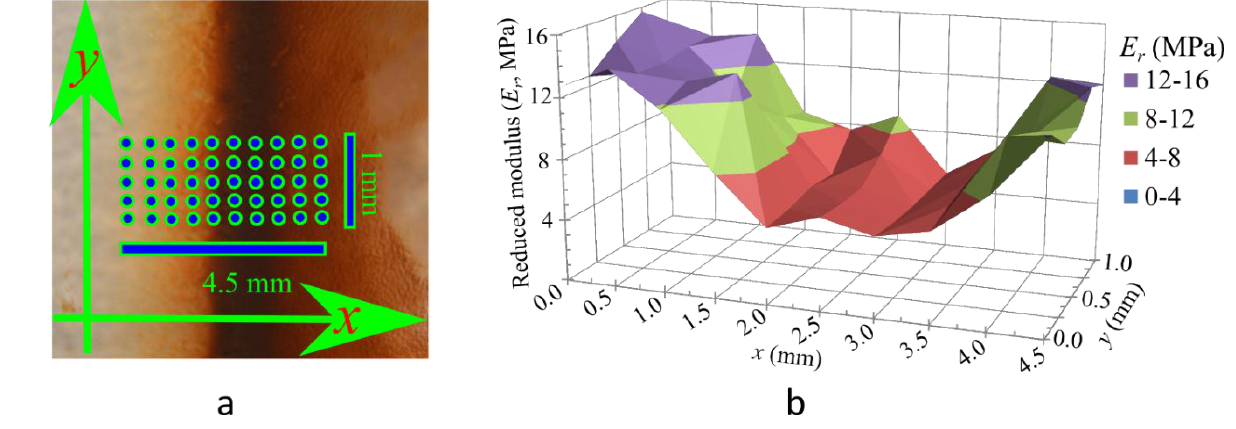
Figure 3. Heterogeneity in E r . ( a ) Sample with ψ * = 0.1% shows that MNP concentration is highest in the region immediately above the periphery of the magnet. Approximate